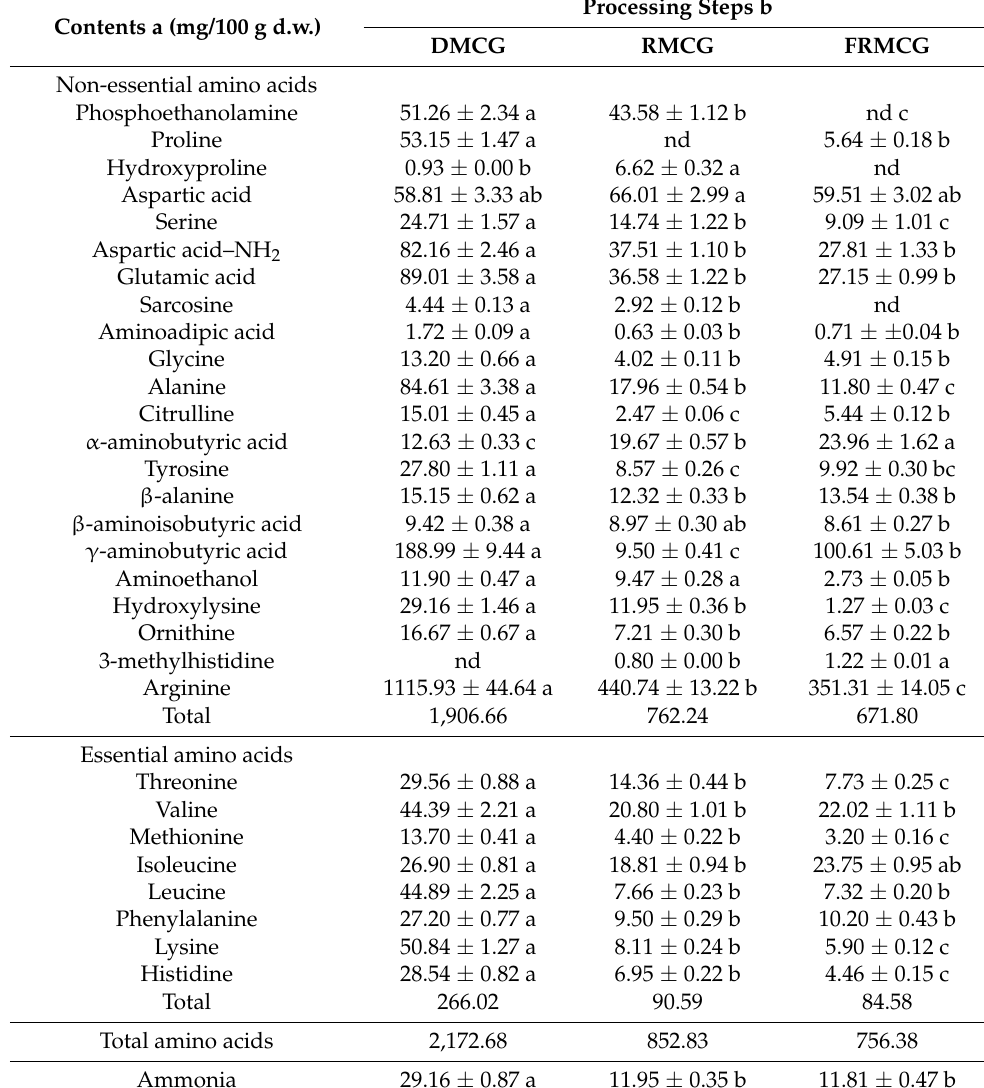
Table 2. Change of the free amino acid contents during food processing steps of mountain-cultivated ginseng by the cocktail lactic acid bacteria. Contents a (mg/100 g